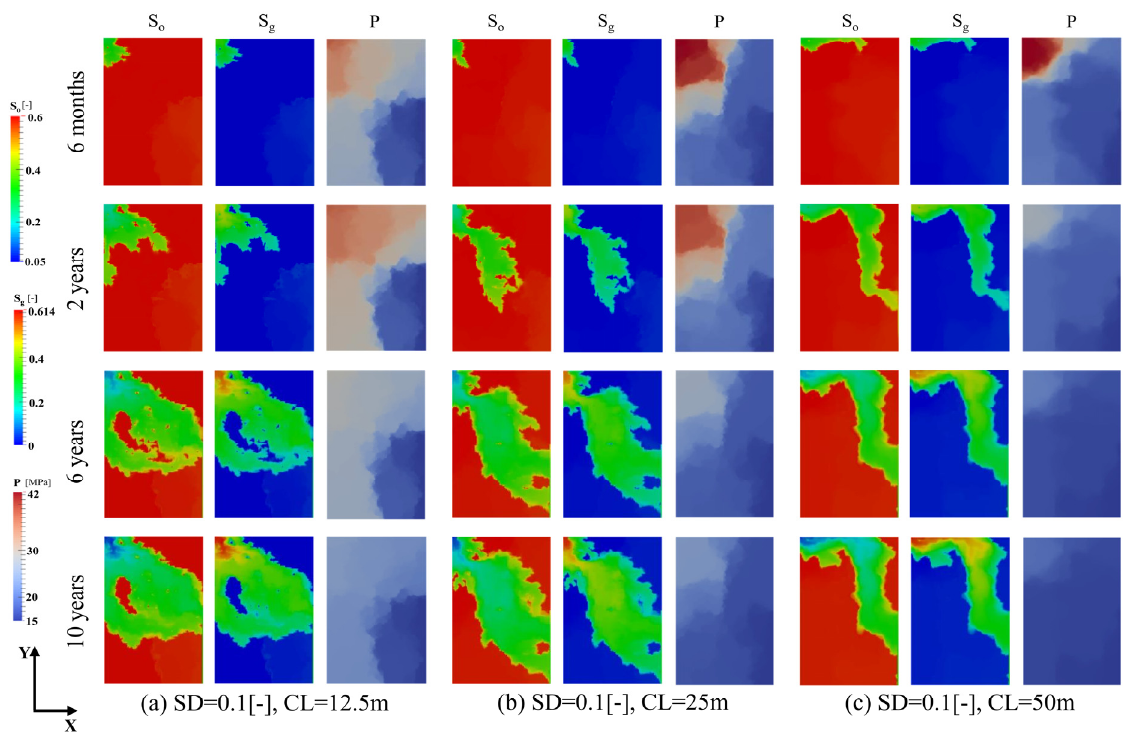
Figure 9. Evolutions of saturation and reservoir pressure fields in Set 3. ( a ) SD = 0.1 (-), CL = 12.5 m; ( b ) SD = 0.1 (-), CL = 25 m; ( c ) SD = 0.1 (-), CL = 50 m.